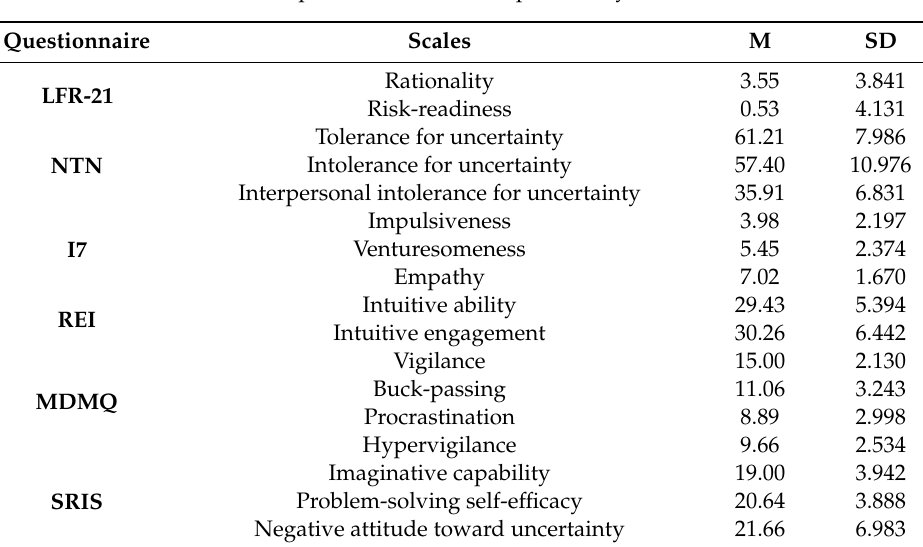
Table A2. Descriptive statistics for the personality